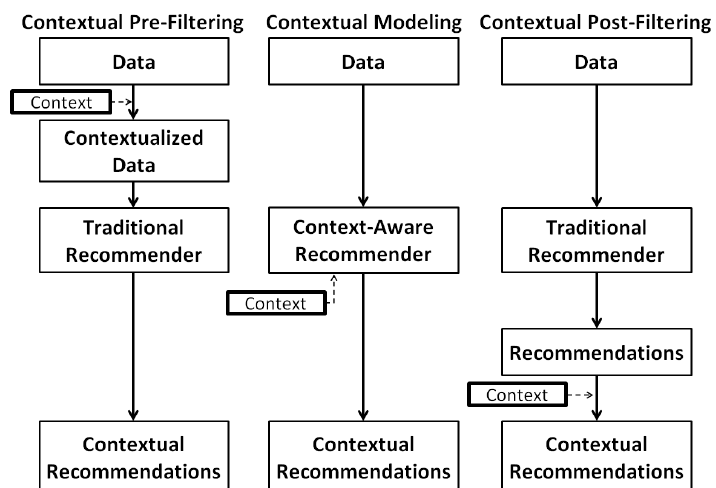
Figure 1. How to use context in the recommendation process (adapted from Panniello and Gorgoglione